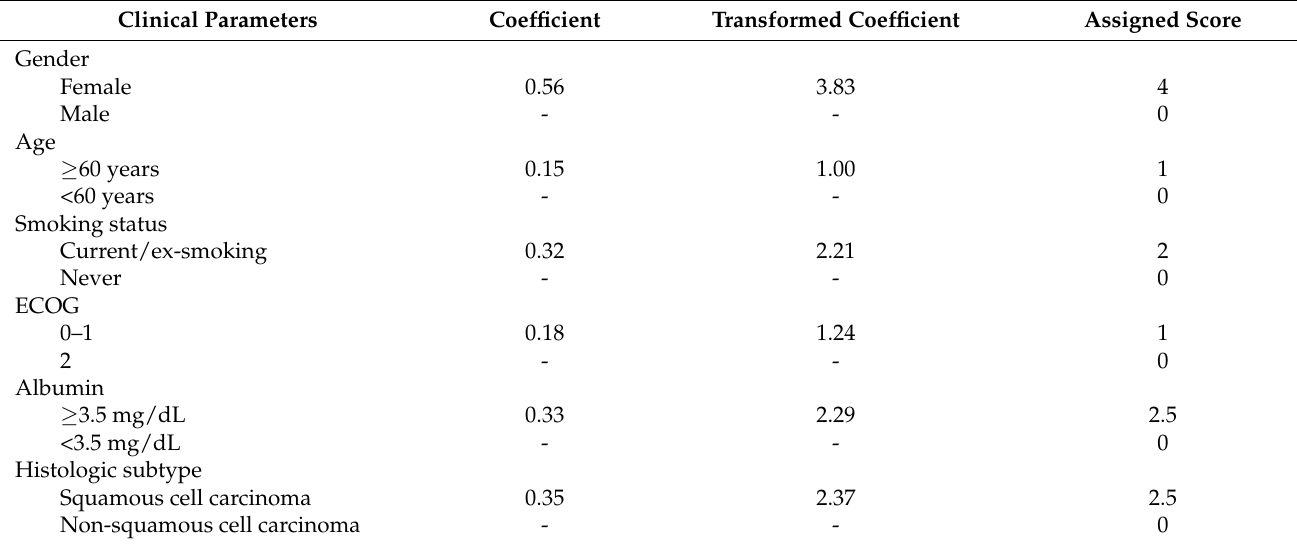
Table 3. Item scoring scheme for responder.